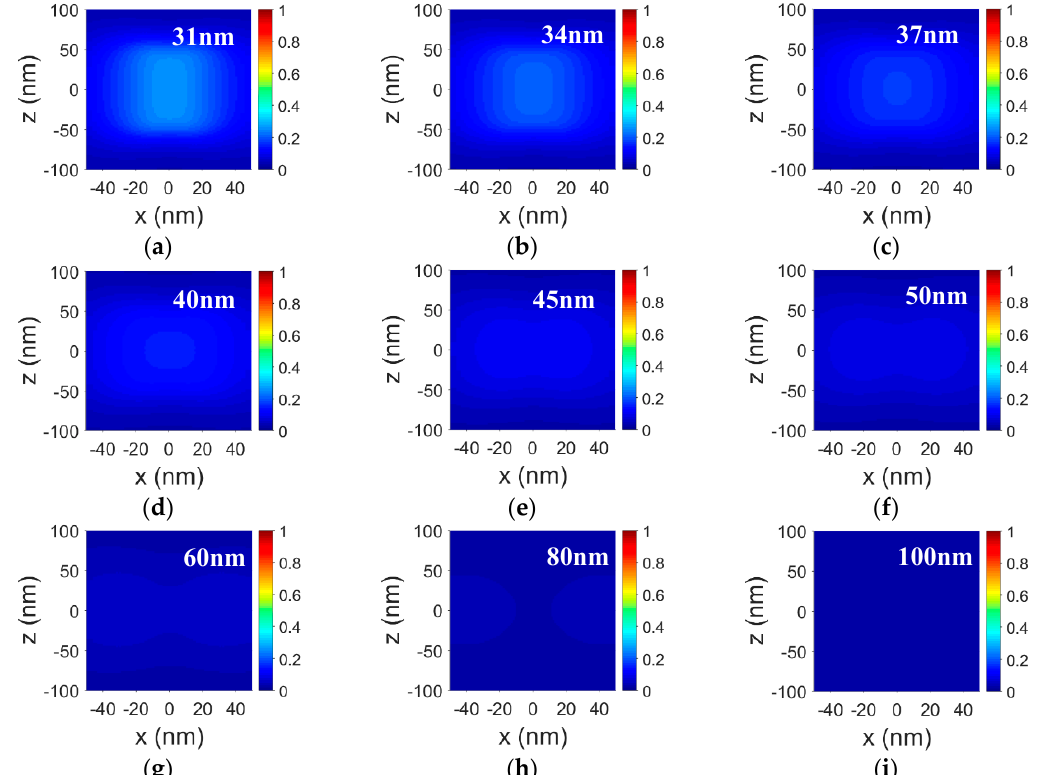
Figure 6. The electric field distributions of the silver nanorod with a diameter of 30 nm and a length of 100 nm for the TM polarization (along the x-direction). ( a – i ) The electric field profiles of E(x, z) at 517 nm in different near field regions when adding the 2D y-normal monitor in the positions of y = 31, 34, 37, 40, 45, 50, 60, 80, and 100 nm, respectively.